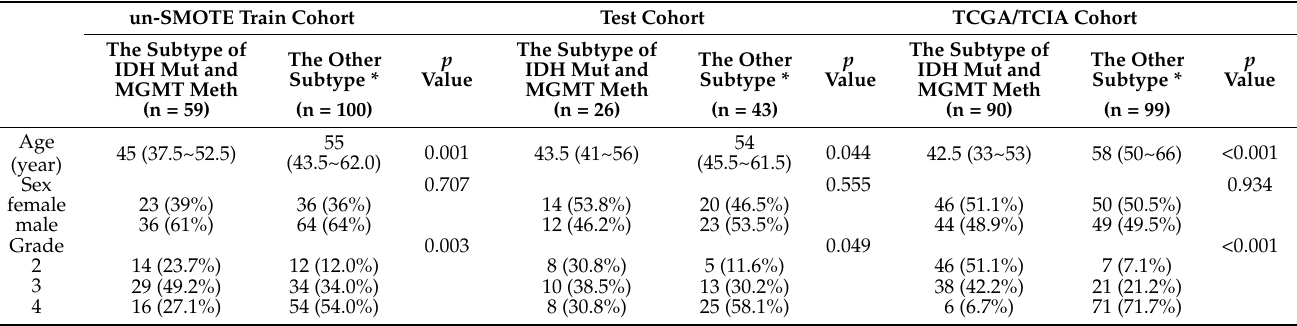
Table 1. Patient characteristics of three